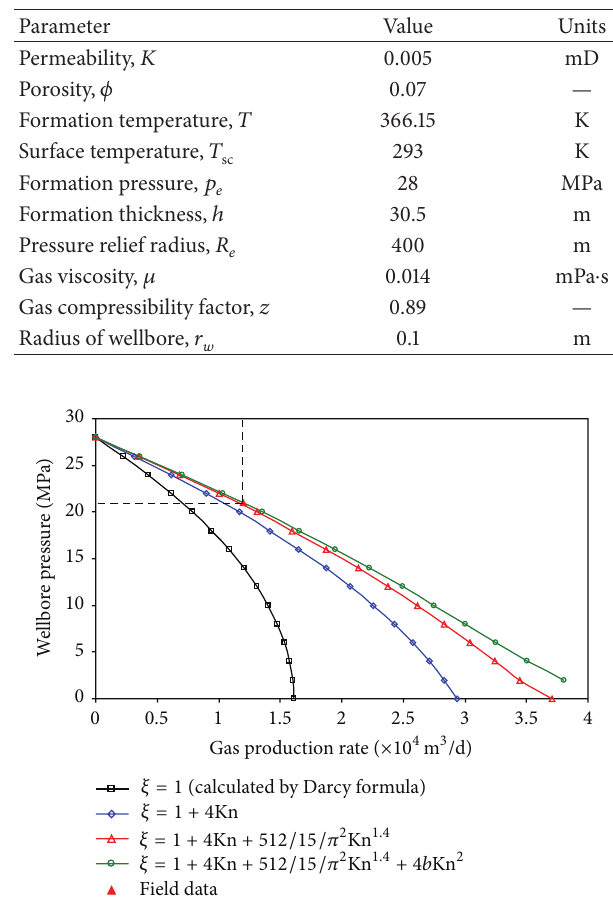
Figure 5: Effect of permeability correction factor 𝜉 on